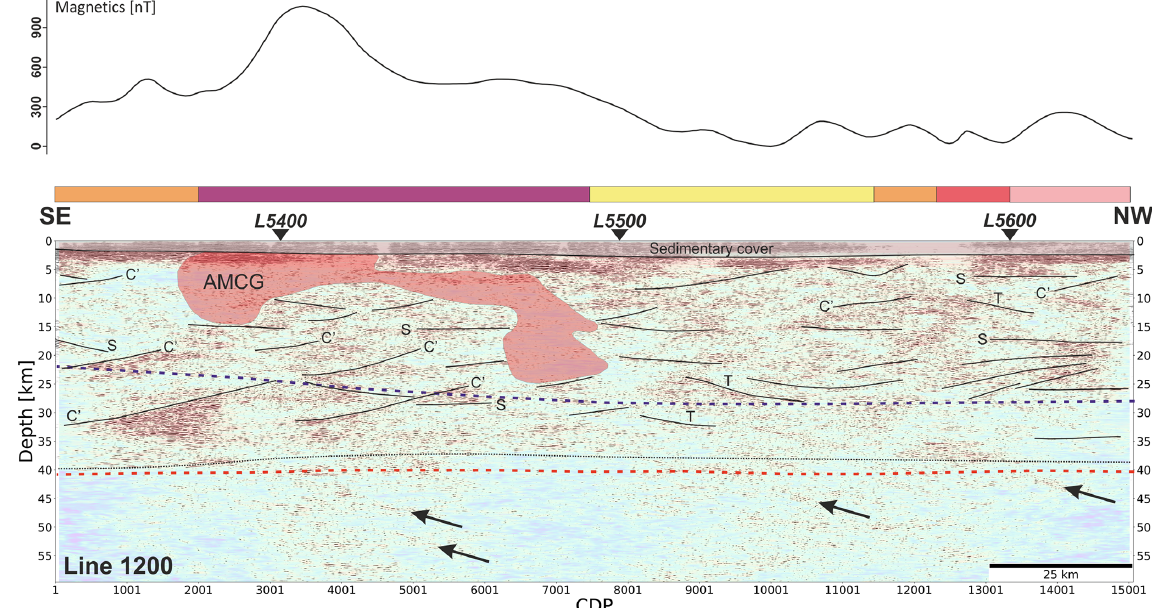
Figure 7. Final migrated depth-converted section along PolandSPAN ™ profile 1200 with preliminary interpretation. Bars atop the section are colour-coded according to the crystalline basement lithologies following Krzemi´nska et al. (2017) (see Fig. 9 for a legend). The magnetic profile at the top is extracted from the magnetic anomaly map (Fig. 3). The dashed blue and red lines represent the top of the lower crust and Moho boundary, respectively, taken from the WARR compilation of Majda´nski (2012). The black dotted line is the interpreted Moho boundary from reflection data. Arrows point to the upper mantle reflectors (RUM). S – subhorizontal structural layering (Svekofennian orogenic fabric); T – ductile thrust shear zones; C (cid:48) – extensional shear zones.